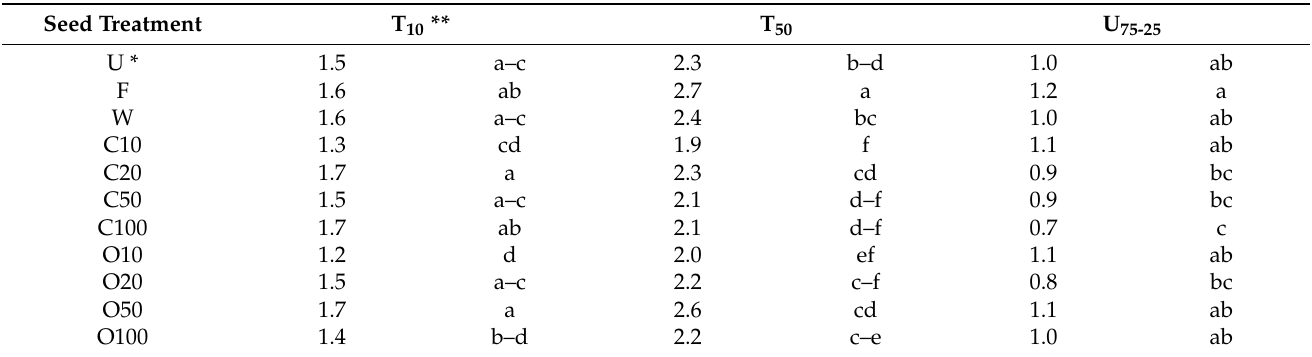
Table 3. Effects of coconut and oregano hydrolates treatment on the speed and uniformity of seed germination of onion seeds of sample I (days).